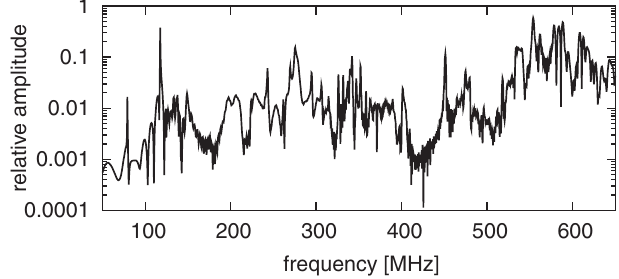
FIG. 17. Field resonances of the IVA cavities determined using the full RITS-6